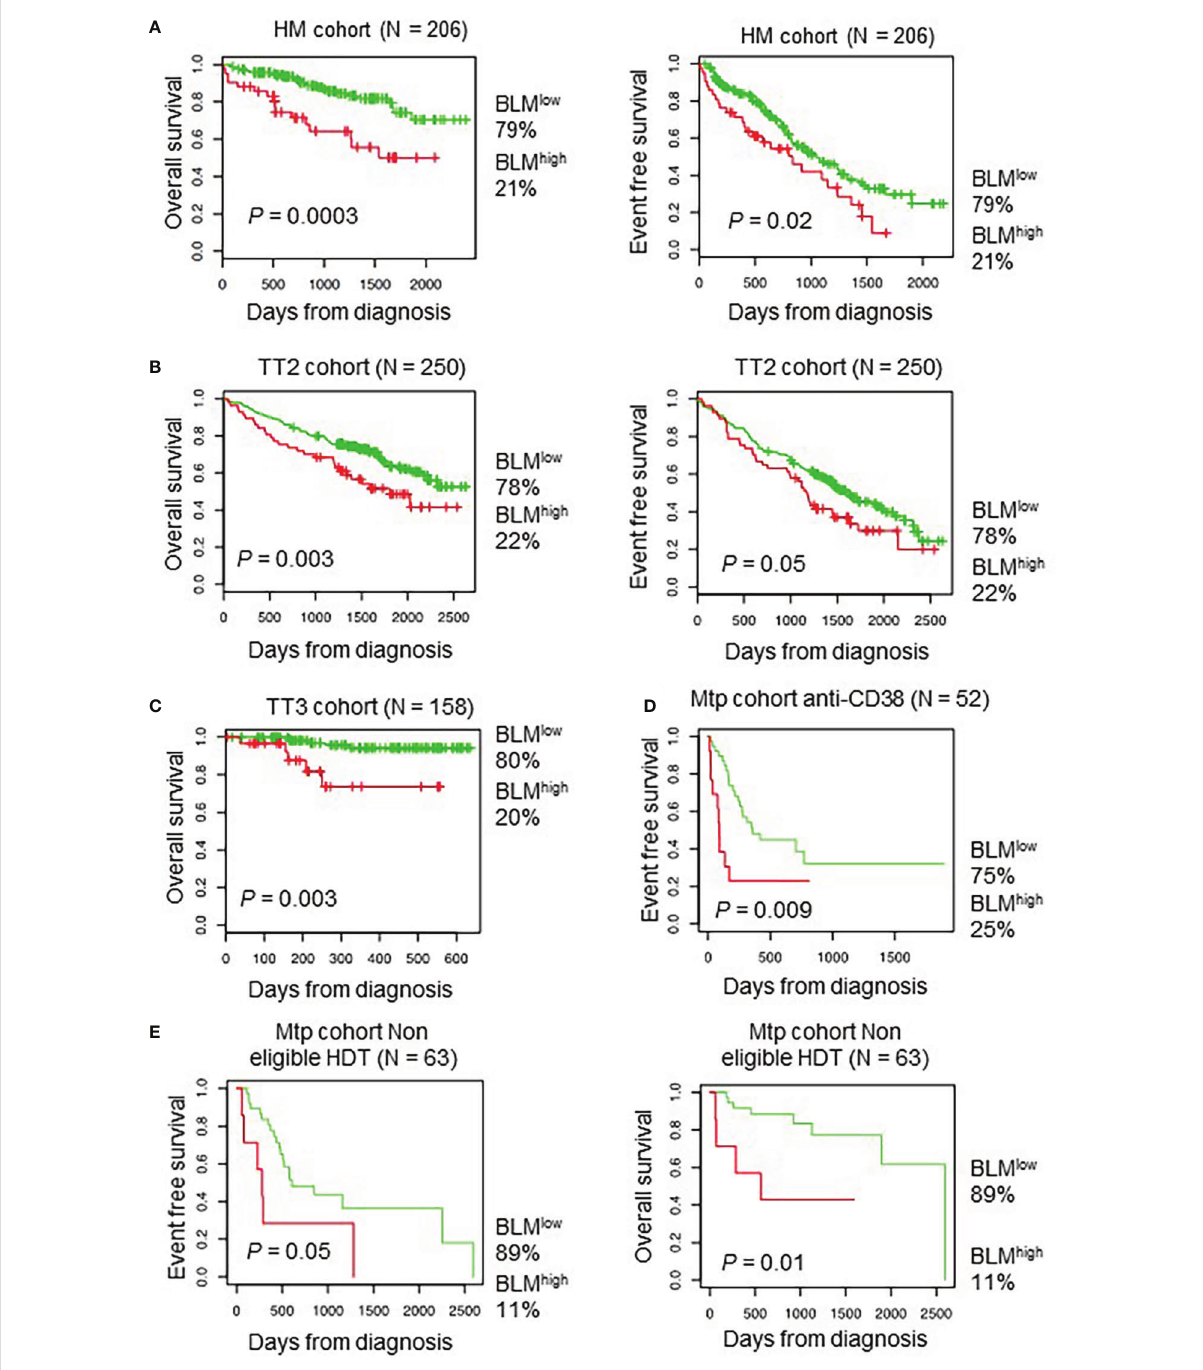
FIGURE 2 High BLM expression is associated with a poor outcome in MM. Correlation between BLM expression and overall survival was analyzed using Maxstat R package in independent cohorts of MM patients: including patients at diagnosis treated by HDT and ASCT ( A , left panel) HM cohort; ( B , left panel) UAMS-TT2 cohort; (C) TT3 cohort; a cohort of patients at relapse treated by Anti-CD38 antibody (Daratumumab) (D) Mtp cohort anti-CD38 and a cohort of patients at diagnosis non eligible to HDT and ASCT (E) Mtp cohort non eligible HDT. ( A, B , right panels) High expression of BLM is associated with shorter event free survival in the HM, TT2 and Mtp cohort non eligible HDT